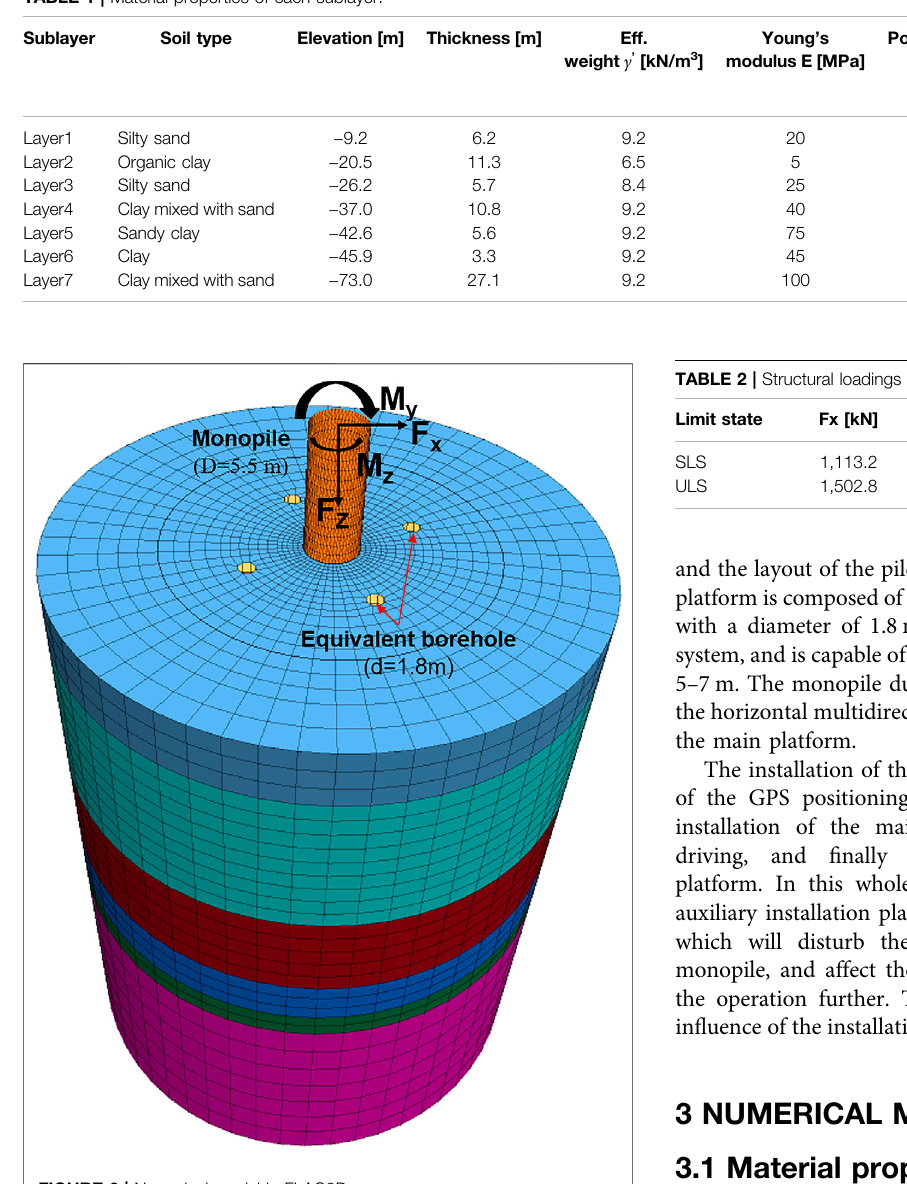
FIGURE 3 | Numerical model in FLAC3D.